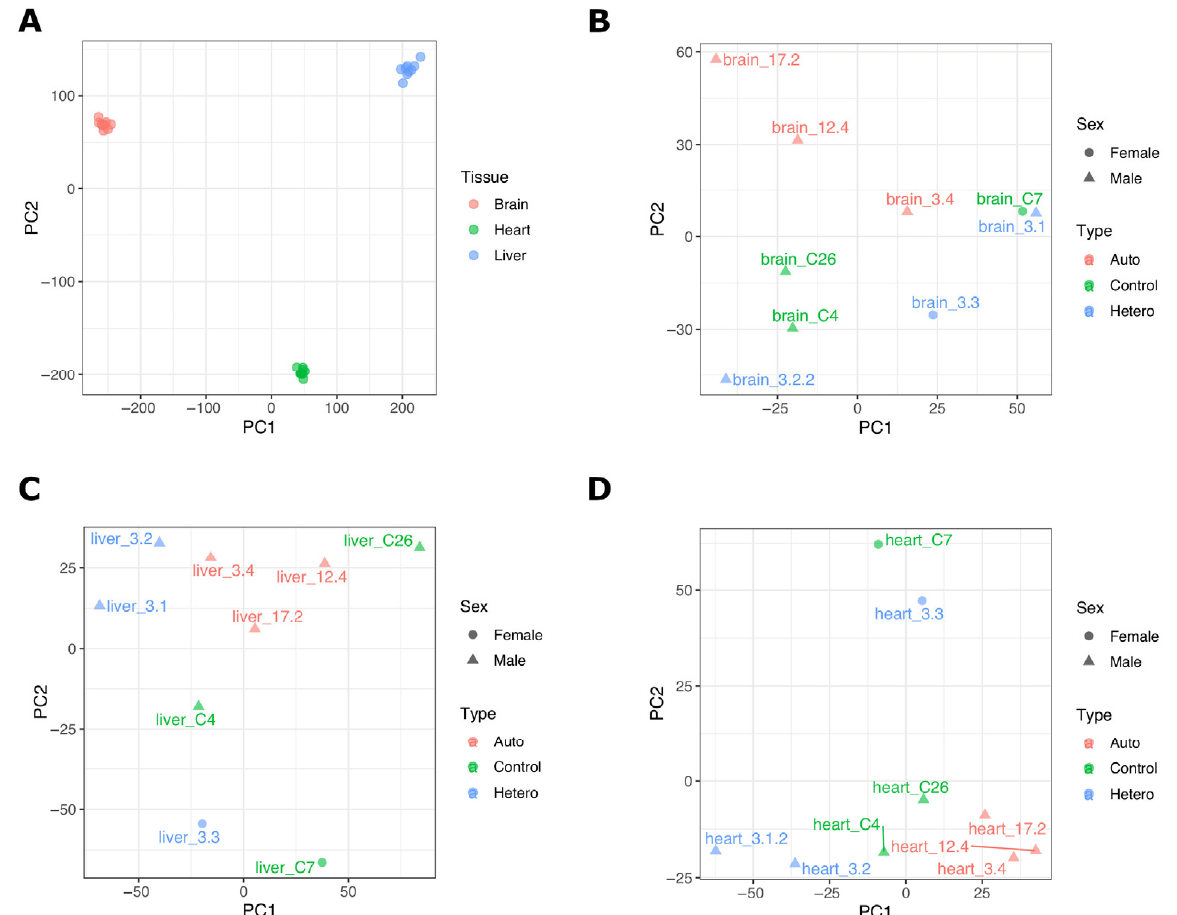
Figure 2. Principal component analysis (PCA) of RNAseq data for liver, heart and brain tissues. ( A ) PCA plot for all tissues used in this study. ( B ) Brain tissue from control and mtDNA-supplemented- derived pigs. ( C ) Liver tissue from control and mtDNA-supplemented-derived pigs. ( D ) Heart tis- sue from control and mtDNA-supplemented-derived pigs. In ( B – D ), control (green), and autolo- gous (orange) and heterologous (blue) mtDNA-supplemented-derived pig data are indicated by di ff erent colours, and the gender of each pig is shown by a triangle (male) or circle (female). Sample metadata and summary statistics for RNAseq data are shown in Table S1.